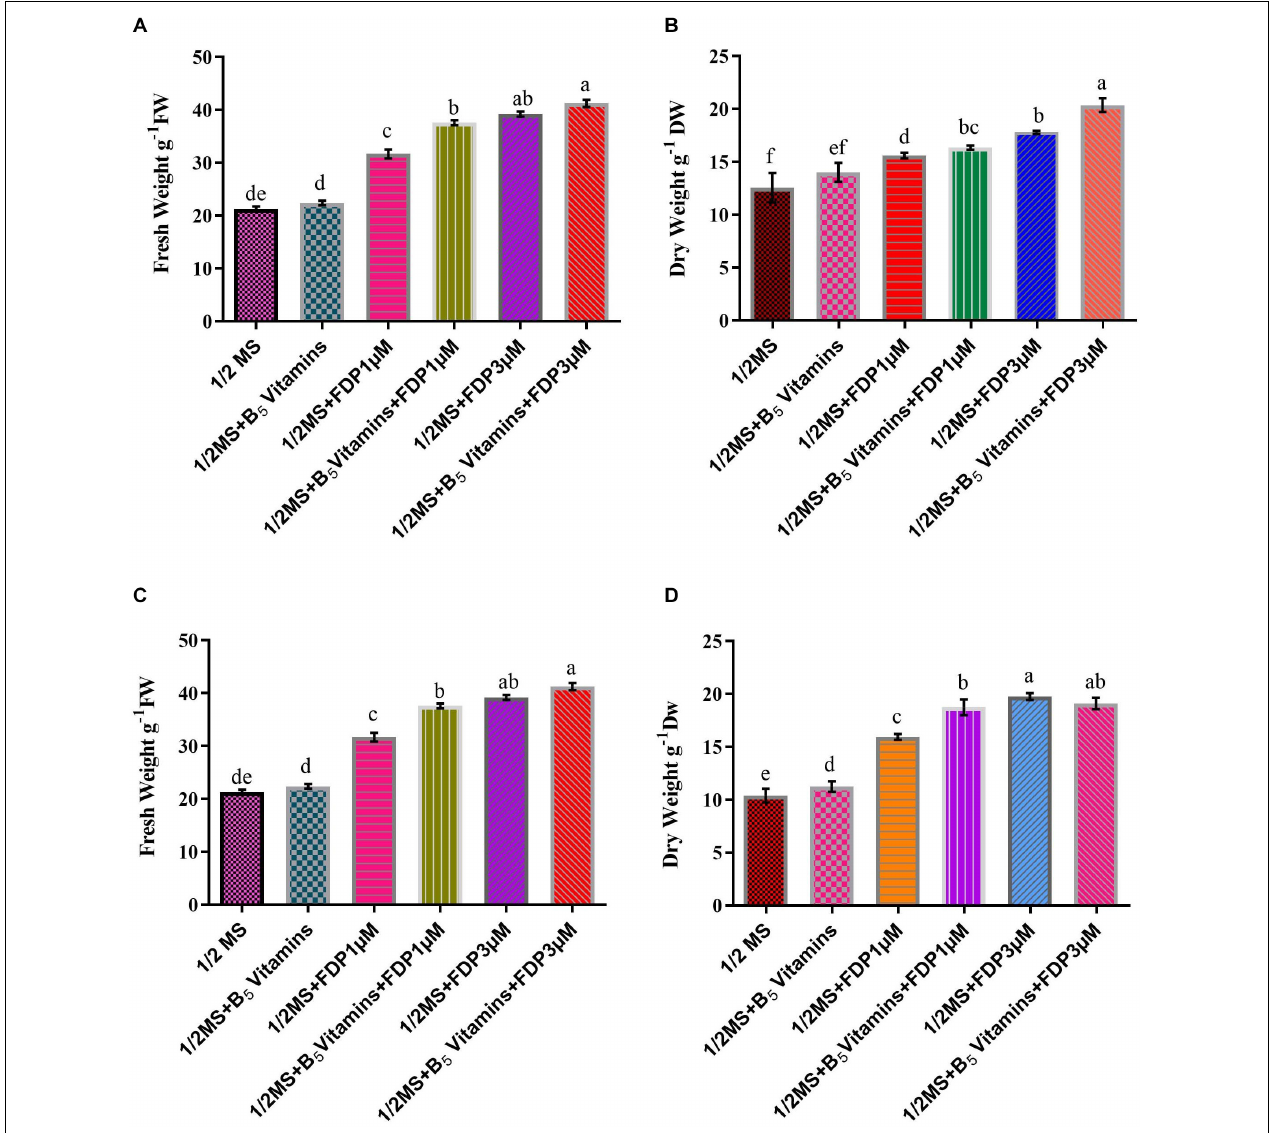
FIGURE 7 | Productivity of precursor treatment of hairy root culture yield and biomass cultivation. (A) Various concentrations of A 4 strain treatment of fresh weight of hairy root culture. (B) Various concentrations of A 4 strain treatment of dry weight of hairy root culture. (C) Various concentrations of R 1000 strain treatment of fresh weight of hairy root culture. (D) Various concentrations of R 1000 strain treatment of dry weight of hairy root